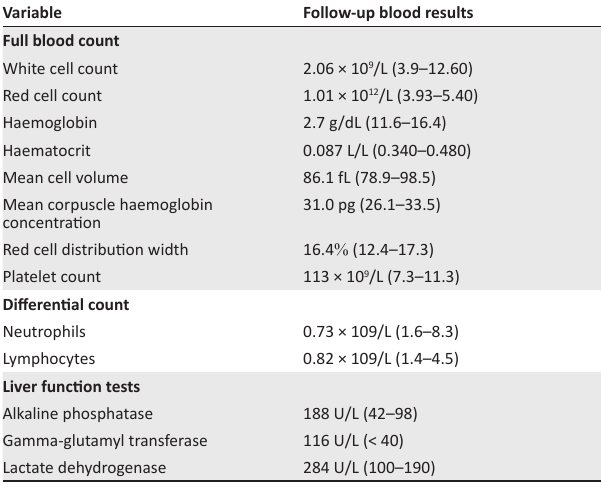
TABLE 2: Follow-up blood